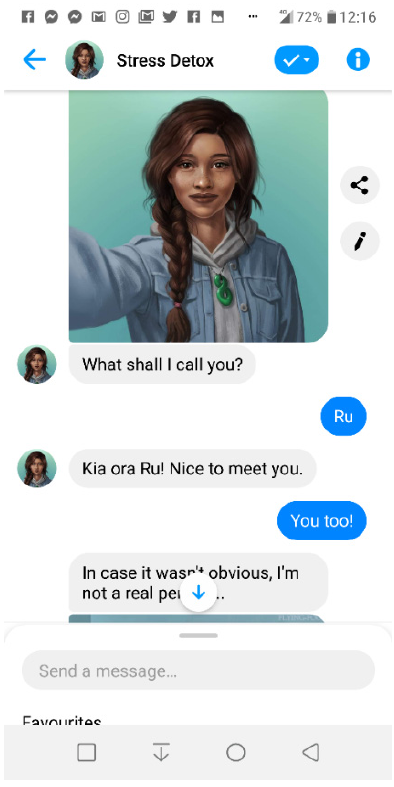
Figure 1. Screenshot of day one onboarding with “Aroha”, the Stress Detox chatbot persona.